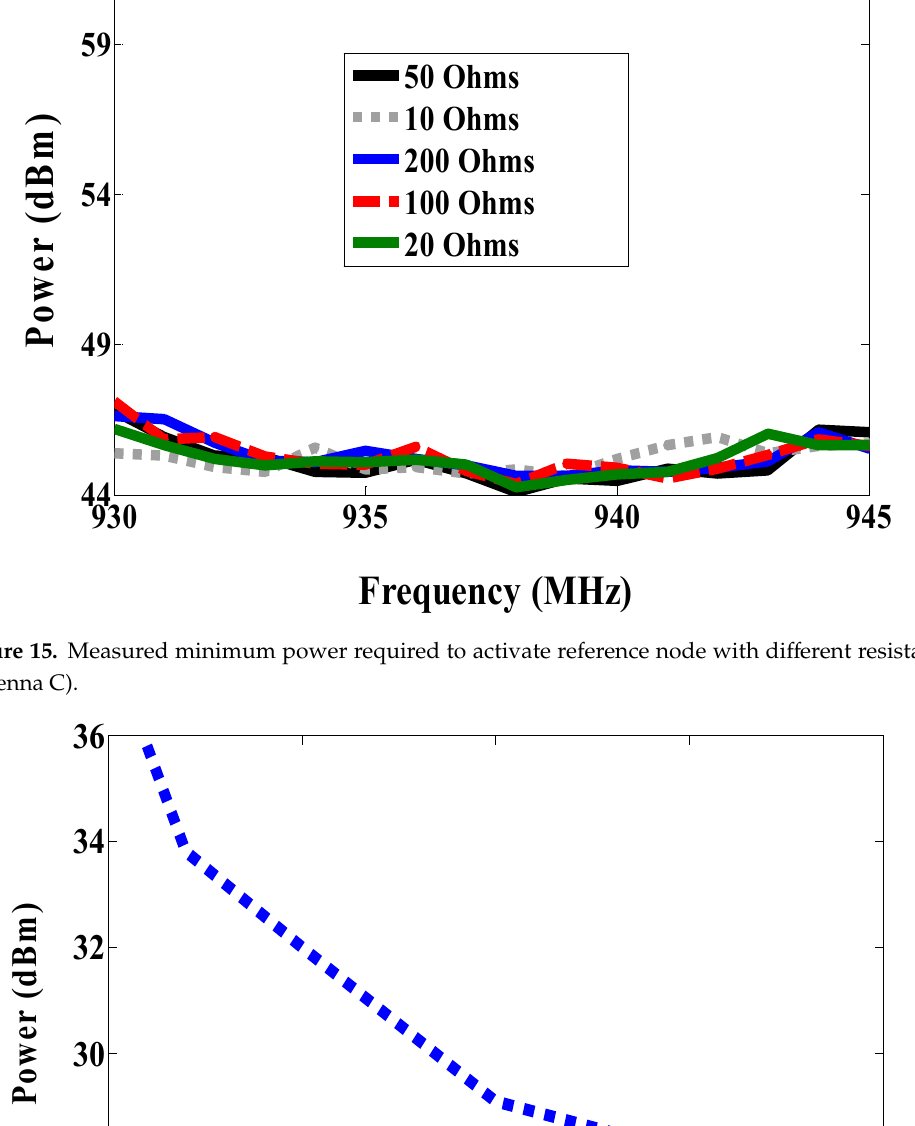
Figure 14. Measured minimum power required to activate sensor node with different resistance (antenna C).